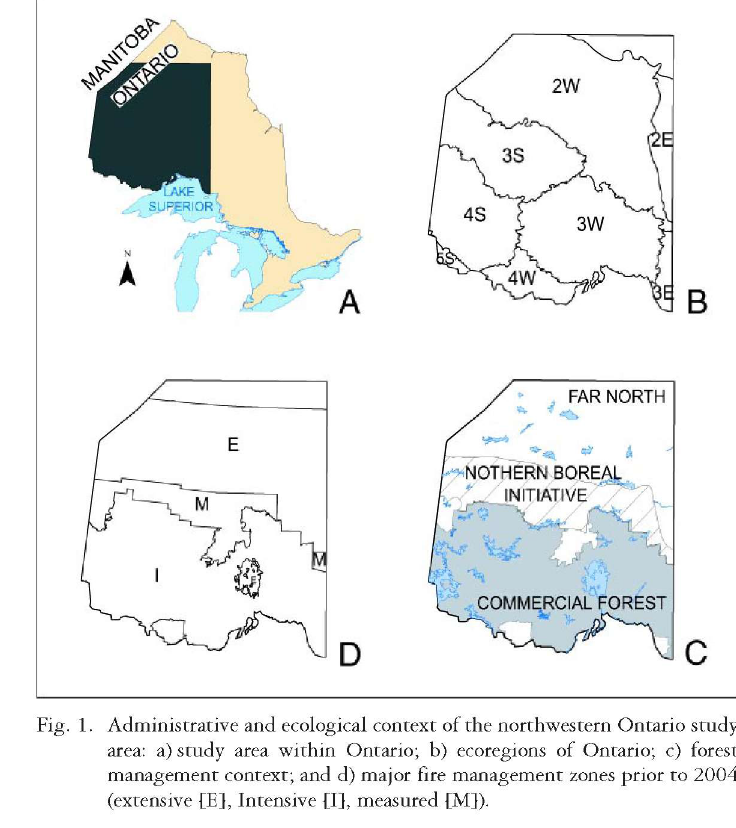
Fig. 1. Administrative and ecological context of the northwestern Ontario study area: a) study area within Ontario; b) ecoregions of Ontario; c) forest management context; and d) major fire management zones prior to 2004 (extensive [E], Intensive [I], measured